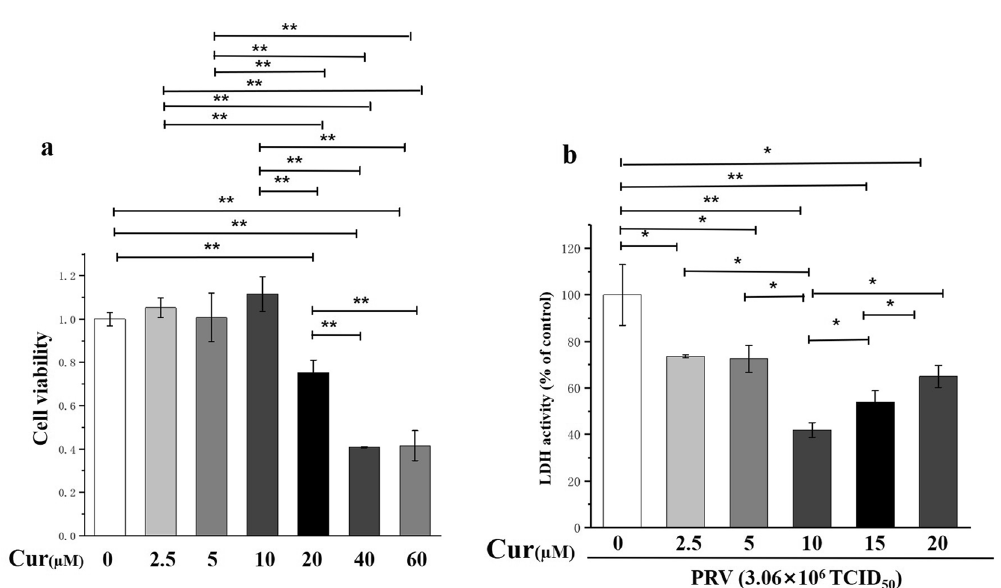
Figure 2. Toxicity and neuroprotective effect of curcumin doses on hippocampal neurons. ( a ) Toxicity of curcumin doses on hippocampal neurons; ( b ) Neuroprotective effect of curcumin doses against hippocampal neurons infected by pseudorabies virus (PRV). n = 3, represents three biological replicates, each performed in triplicate. *P < 0.05; **P < 0.01, based on one-way analysis of variance (ANOVA) followed by least significant difference (LSD) post hoc test for multiple